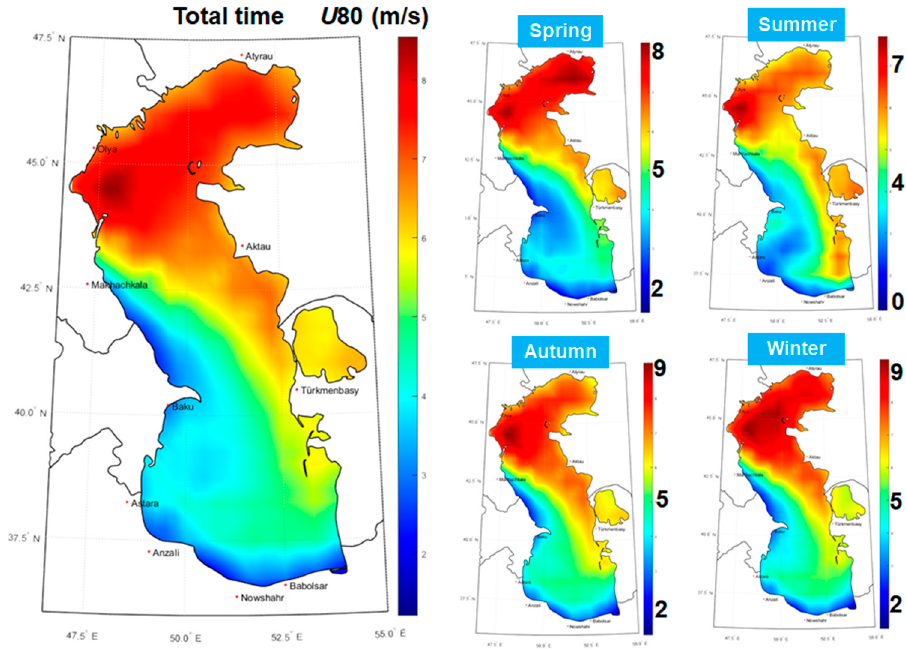
Figure 3. Spatial distribution of the U80 parameter (average values) considering the 20-year time interval (January 1999 to December 2018) of ERA-Interim data.